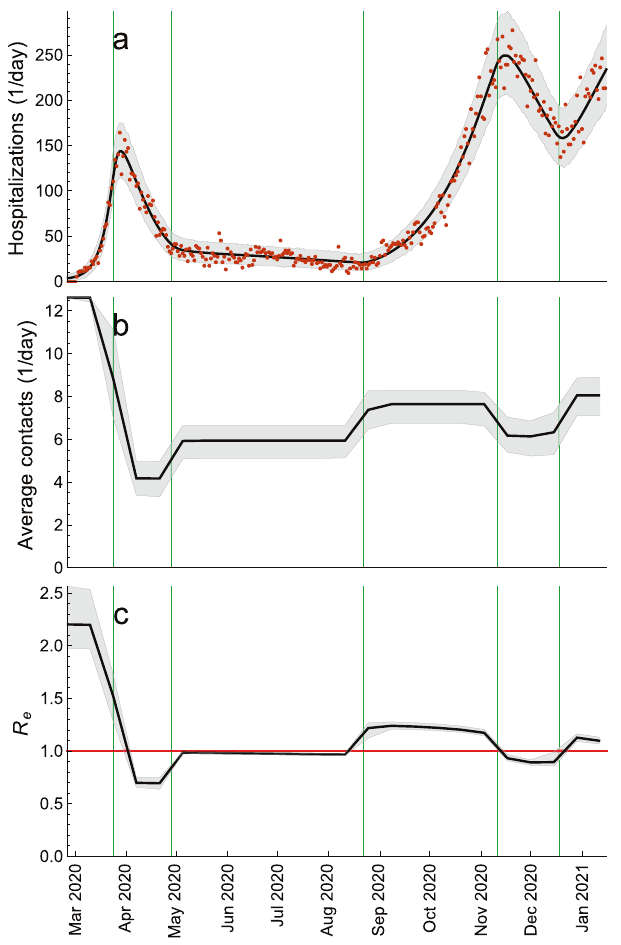
Fig. 3 Estimated contact rate and effective reproduction number. a Total daily hospital admissions with COVID-19. b Average (over all ages) number of daily contacts in the population. c Effective reproduction number, R e ( t ). The average daily contacts and R e were evaluated once every two weeks. The green vertical lines indicate the estimated mid-point transitions in the age-speci fi c contact rates. The red horizontal line denotes R e = 1. The hospitalization data are shown as red dots. The black solid lines are the median trajectories estimated from the model. The gray shaded regions correspond to 95% credible